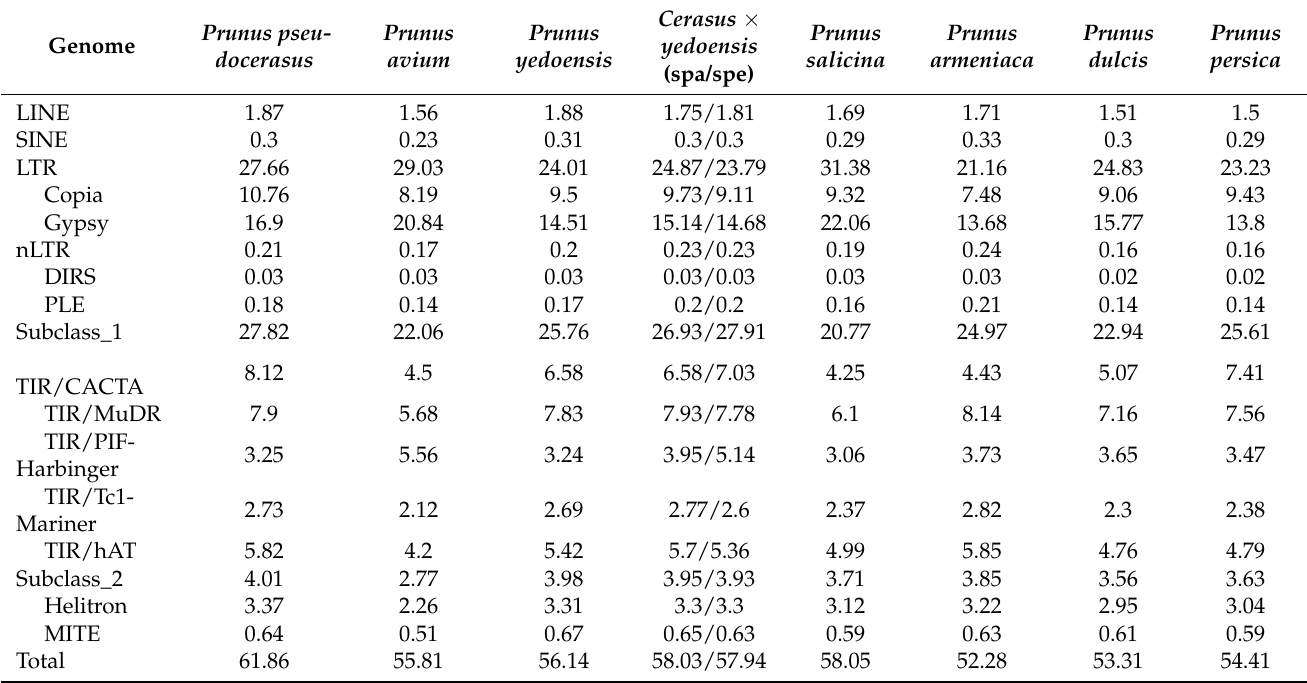
Table 2. Proportions of TEs and TRs in eleven haploid genomes of eight taxa in the Prunus subgenus Cerasus and its